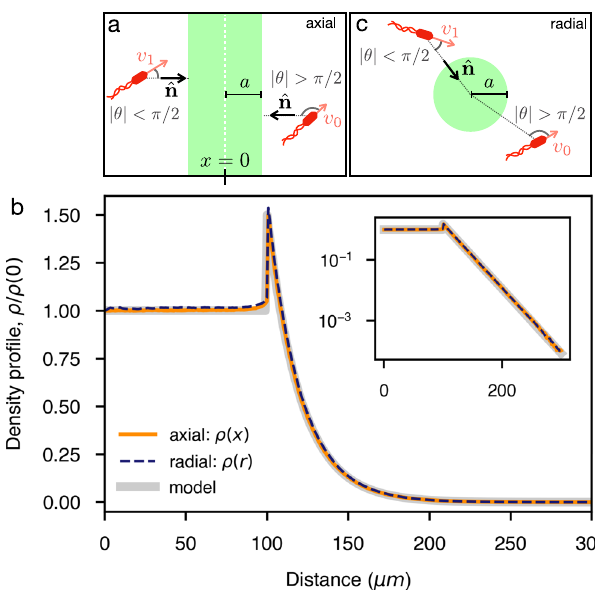
Fig. 3 Run and tumble particles in 2D with axial and radial feedback. a Schematic showing the axial geometry to accumulate cells in a band of thickness a . b Simulation results for the stationary density pro fi les in cases of radial and axial recti fi cation, and comparison with the theoretical model. Inset shows results in a semi-log plot. The parameters are v 0 = 5 μ m s − 1 , v c Schematic showing the radial